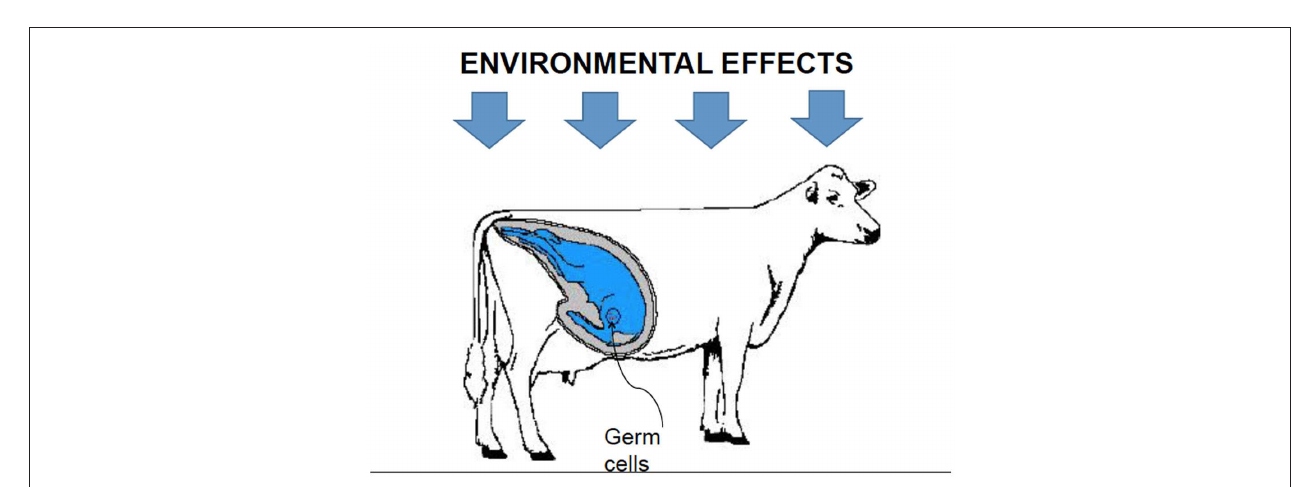
Figure 1 | Simple representation of the effect of methylated DNA.